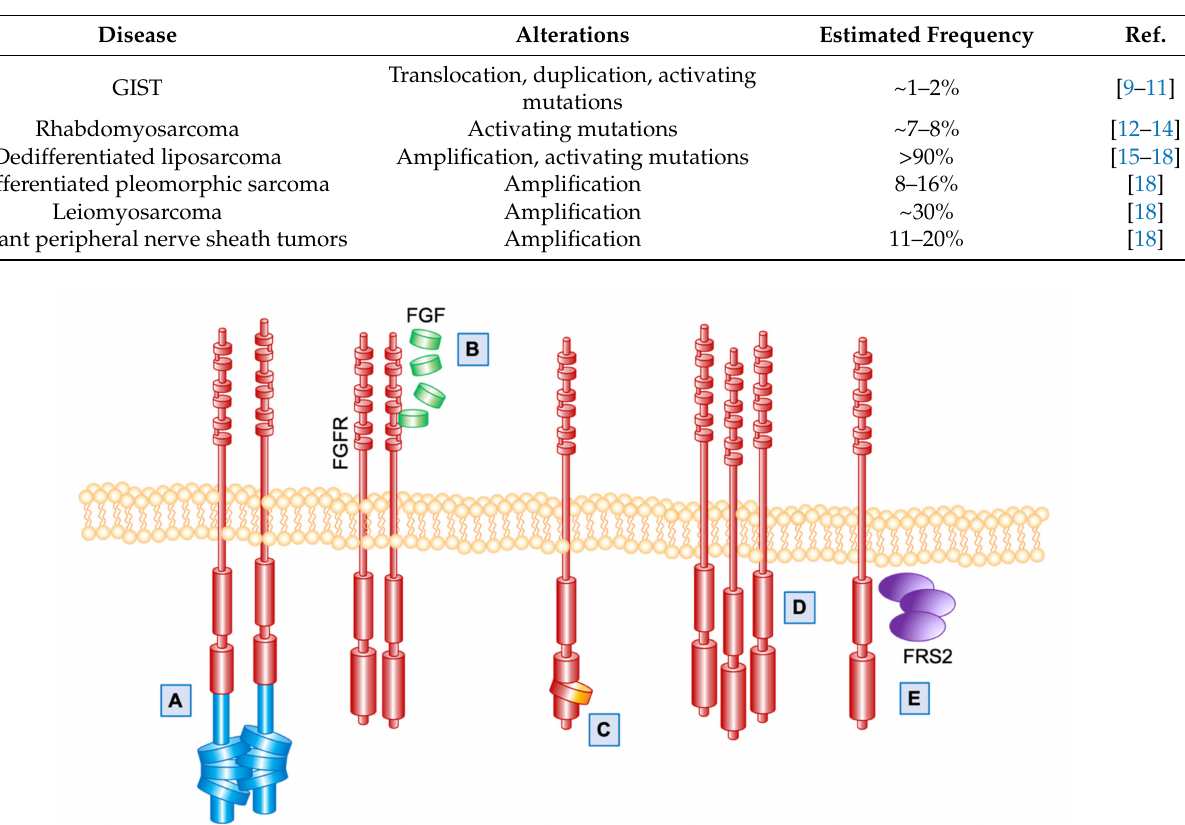
Table 1. Estimated frequency of FGFR pathway alterations in GIST and STS.